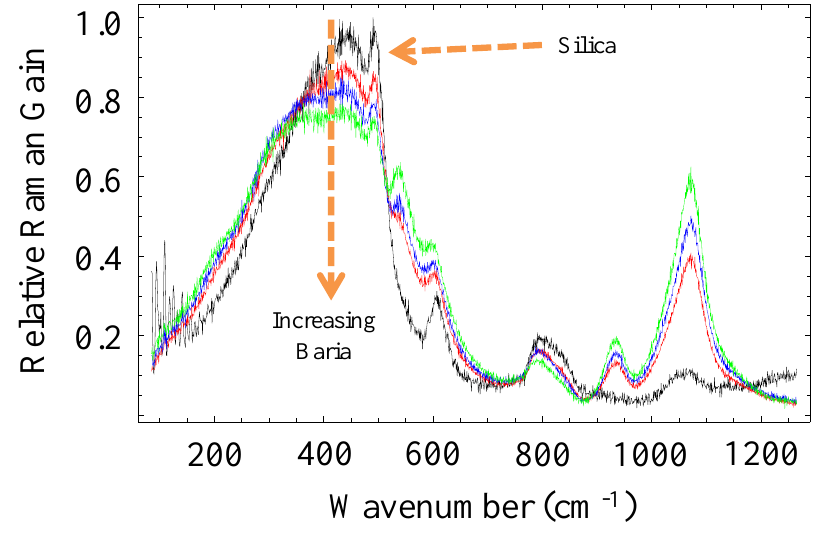
Figure 2. Raman gain spectra (normalized to silica) measured from the barium oxide (BaO) derived fiber for three different baria concentrations. Several new lines appear, likely attributable to the Ba-O bond, including a strong one near 1071 cm −1 . The silica spectrum (black line) was obtained from the fiber cladding of one of the